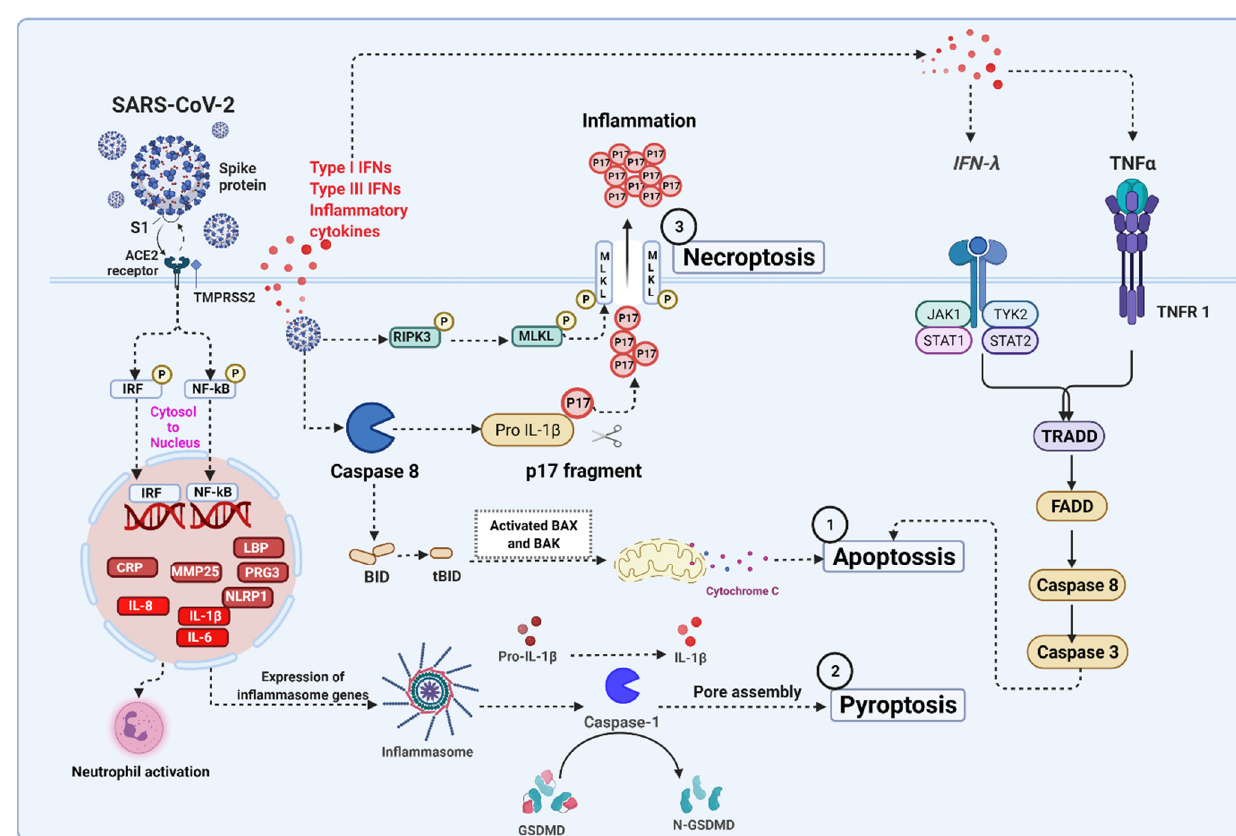
Figure 4. Cell death signaling in severe acute respiratory syndrome coronavirus 2 (SARS-CoV-2) infection: Mechanisms of cell death induced by proteins and cytokines produced by SARS-CoV-2. An increase in inflammatory cytokines is caused by the stimulation of nuclear factor kappa B (NF- κ B) signaling by SARS-CoV-2. In response to binding of the angiotensin-converting enzyme 2 (ACE2) receptor, tumor necrosis factor-alpha (TNF- α ) and interferon-gamma (IFN- γ ) have a multiplicity of effects: (1) apoptosis is induced by the intrinsic pathway; (2) necroptosis is triggered by the phosphorylation of mixed lineage kinase domain-like (MLKL); (3) (A) pyroptosis occurs when inactive gasdermin is cleaved to form membrane pores by its active form. (B) The envelope (E) protein facilitates Ca 2+ leakage from endoplasmic reticulum into the cytosol, and SARS-CoV-2 mediates K + efflux from the viral membrane to the cytosol. This causes mitochondrial damage as well as reactive oxygen species (ROS) production, thereby triggering pyroptosis induced by NLR family pyrin domain-containing 3 (NLRP3) inflammasome. (C) SARS-CoV-2 enhances the pyroptosis pathway by promoting TNFR-associated factor 3 (TRAF3) -mediated ubiquitination of apoptosis-associated